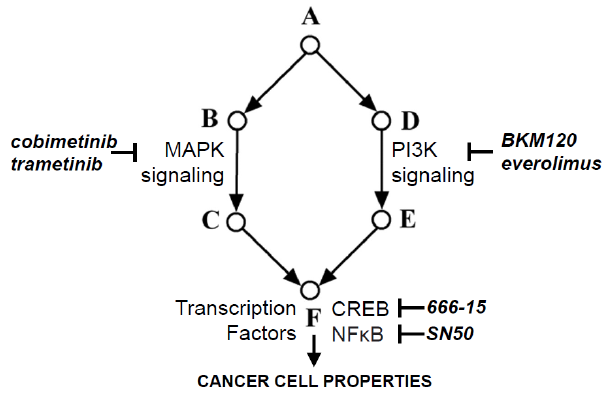
Figure 1. Oncogenic signaling network showing the information flow from growth factor receptors (A), via intracellular signaling pathways (B-E), where mitogen-activated protein kinase (MAPK) and phosphatidylinositol 3-kinase (PI3K) signaling are most often involved. The PI3K and MAPK pathways signal to multiple transcription factor hubs (F), including pivotal transcription factors, such as CREB and NF κ B, each of which regulates the expression of hundreds of genes, the protein products of which regulate key cancer cell oncogenic properties, including survival, proliferation, differentiation, migration and drug resistance. For each targetable factor, the corresponding drug inhibitor is